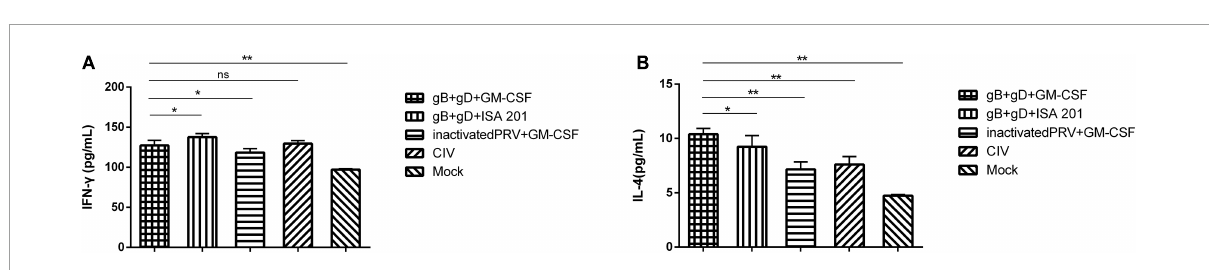
FIGURE5 Cellular immune responses analysis in immunized rabbits. IFN- γ (A) and IL-4 (B) levels in serum at 28 dpi were detected. Data were analyzed by one-way ANOVA using GraphPad Prism software. Significance is presented as * p < 0.05, ** p < 0.01. Error bars represent SD